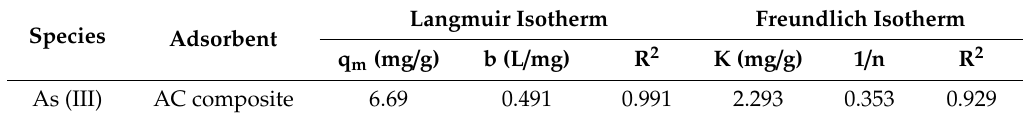
Figure 5. Langmuir isotherm for the adsorption of As (III) onto the composite with error bars. Table 1. Langmuir and Freundlich parameters for the adsorption of As (III) onto the composite adsorbent.